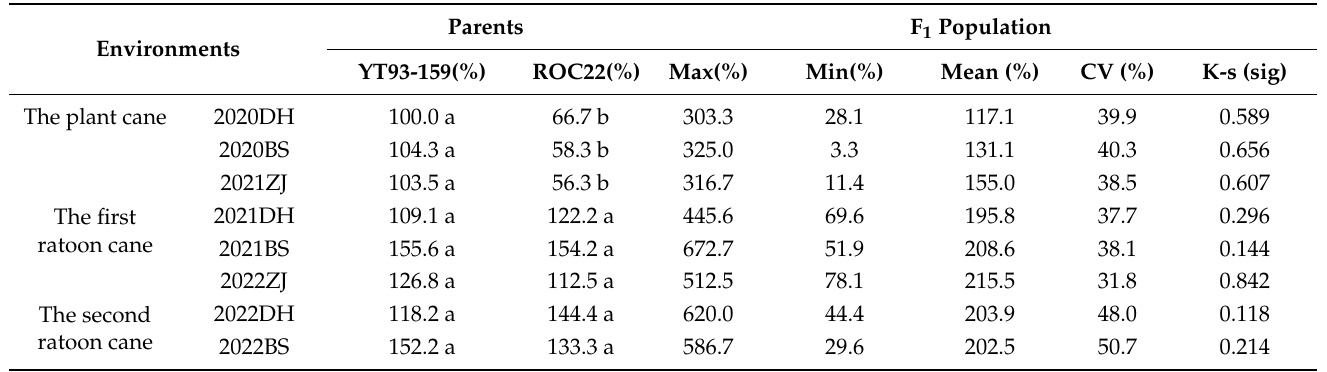
Table 1. Statistical analysis of phenotypic data of the parents and the F 1 population.